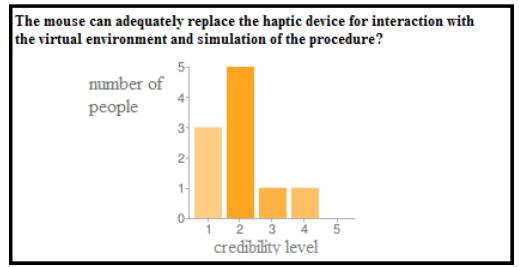
Figure 24. ViMeTGame evaluation question about pressure that the time could cause. Scale: 1 to “Disagree”and 5 to “Fully agree ”.